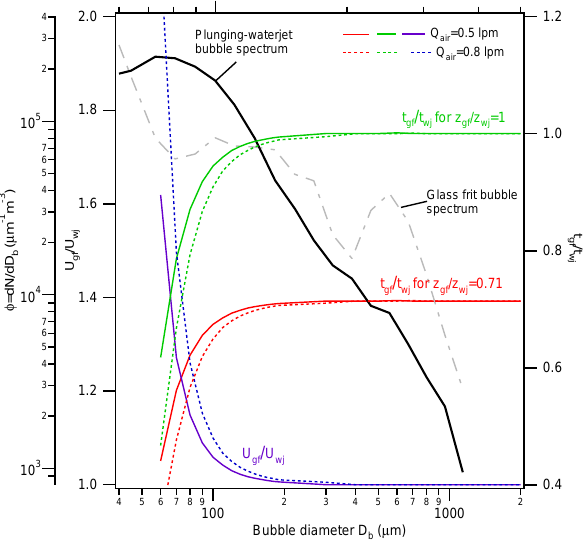
Fig. 10. Glass frit to plunging-water jet bubble rise velocity ratio ( U gf / U wj ) and residence time ratio ( t gf / t wj ) for two different aer- ation flows through the glass frit and bubble path ratios z gf / z wj =1 and 0.71. Bubble population distributions generated by the glass frit (5.2lpm air flow) and the single plunging-water jet system (5lpm water flow) are included for comparison.